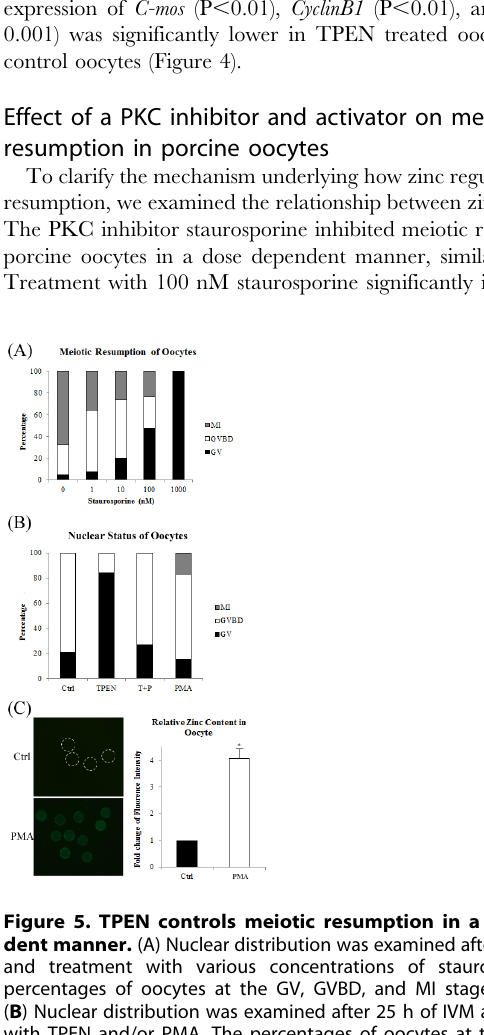
Figure 4. TPEN treatment affects the expression of maternal genes in porcine oocytes. TPEN treatment significantly decreases the mRNA levels of the MPF pathway-related genes Cdc2 and CyclinB1 and the MAPK pathway-related gene C-mos . Data are expressed as mean values 6 SEM of three independent experiments. Ctrl, control group. **, P , 0.01; ***, P ,